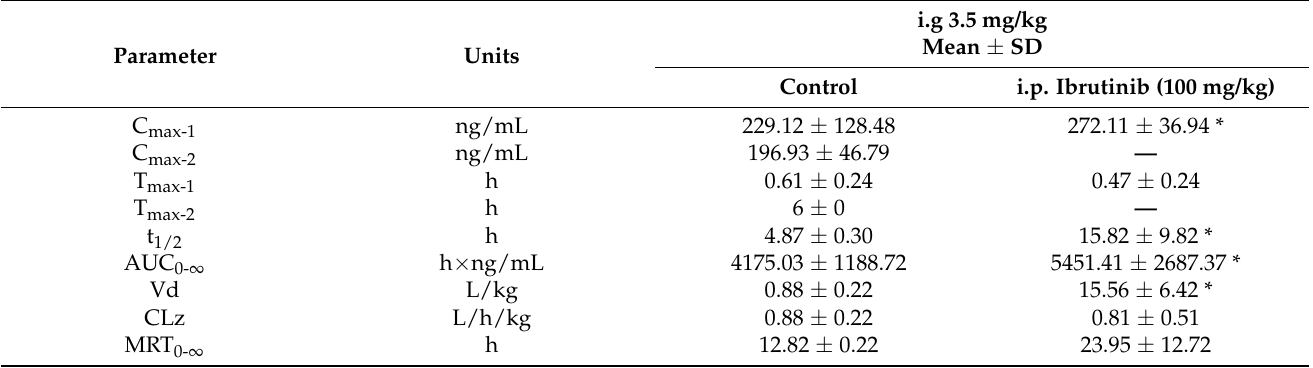
Figure 8. Plasma concentration–time profiles of PND after oral administration (3.5 mg/kg) of PND combined with or without ibrutinib pretreatment (i.p. 100 mg/kg) in rats ( n = 3 ). Table 4. Pharmacokinetic parameters of PND in rats after combination with or without ibrutinib ( n = 3 ).